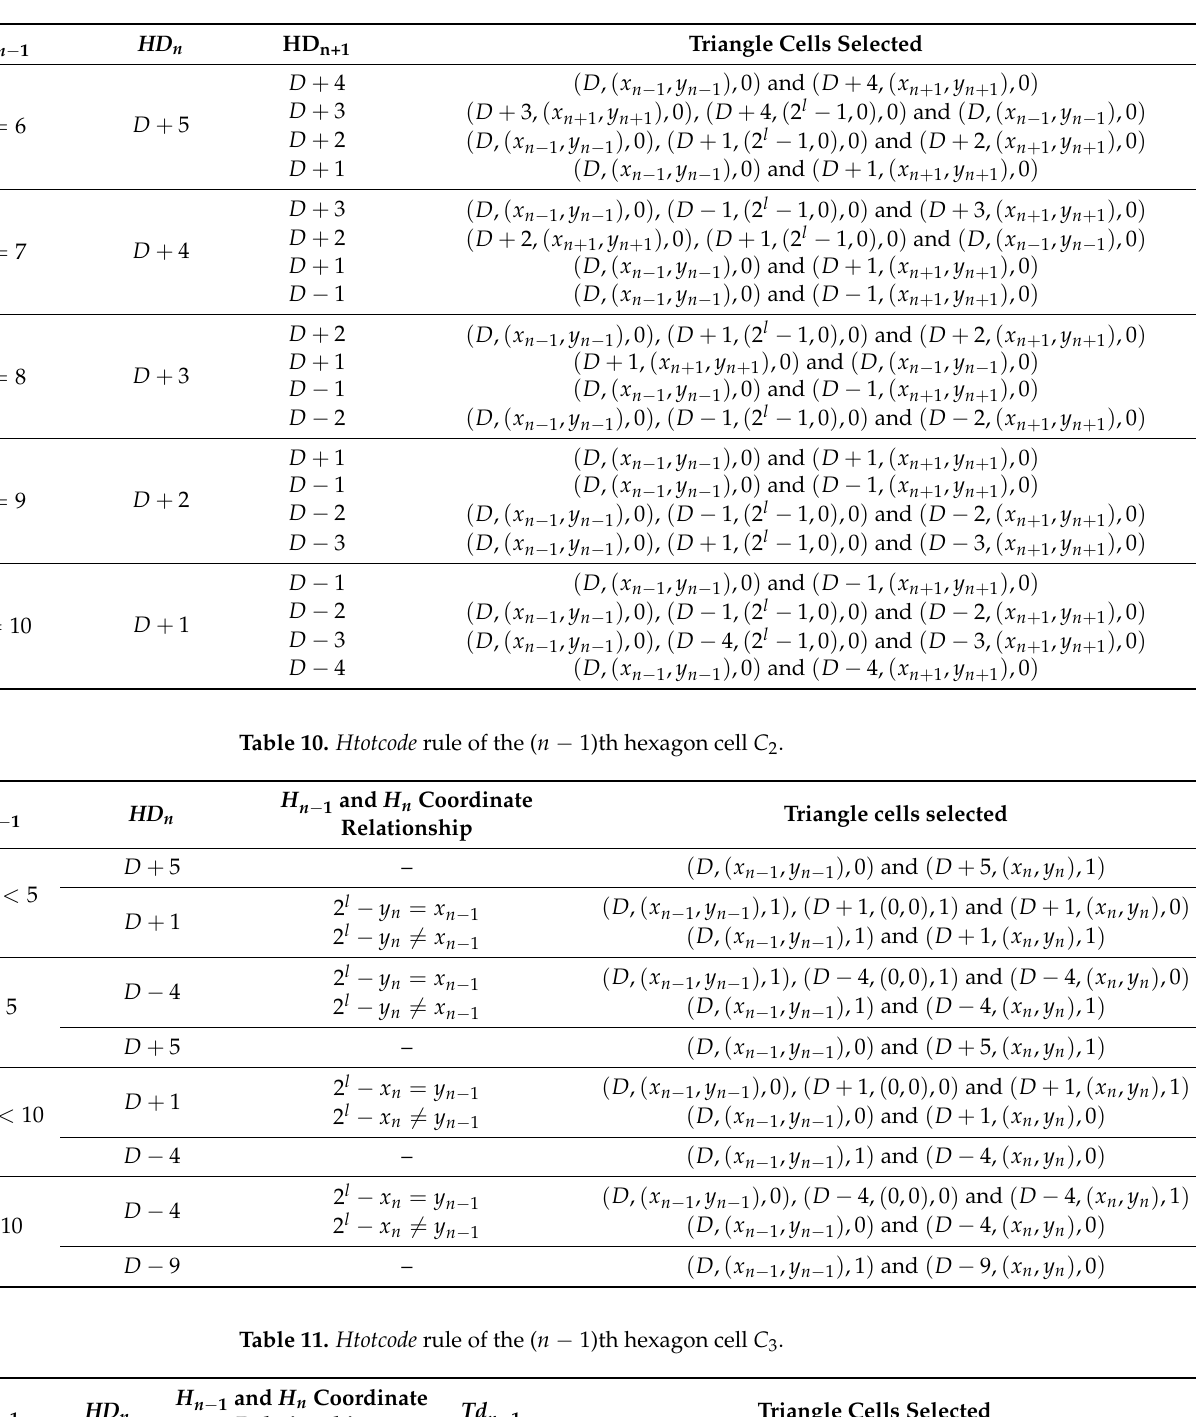
Table 9. Htotcode rule of the ( n − 1)th hexagon cell C 1 and the n th hexagon cell E 2 .